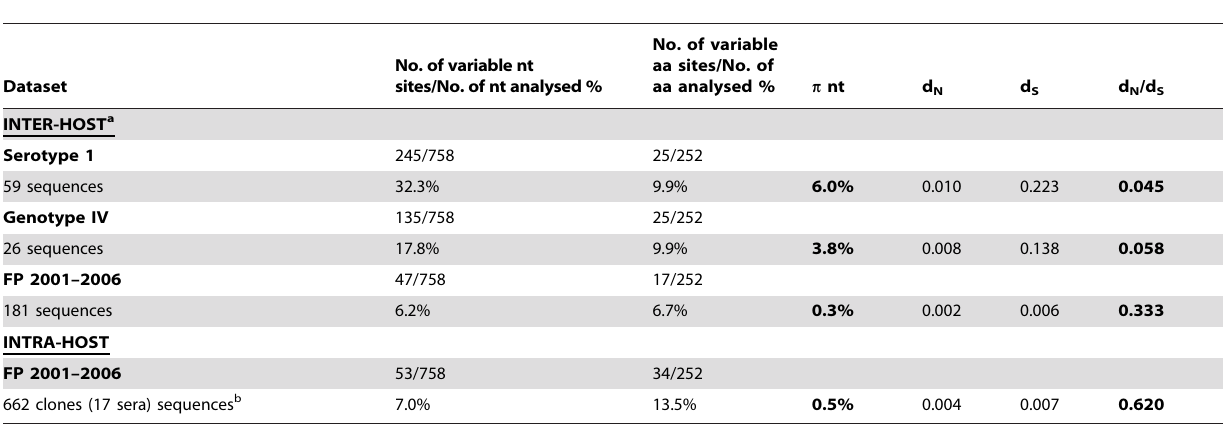
Table 5. Analysis of genetic variability in DENV-1 at different levels of evolutionary divergence based on a 758 nt fragment in the E-gene.